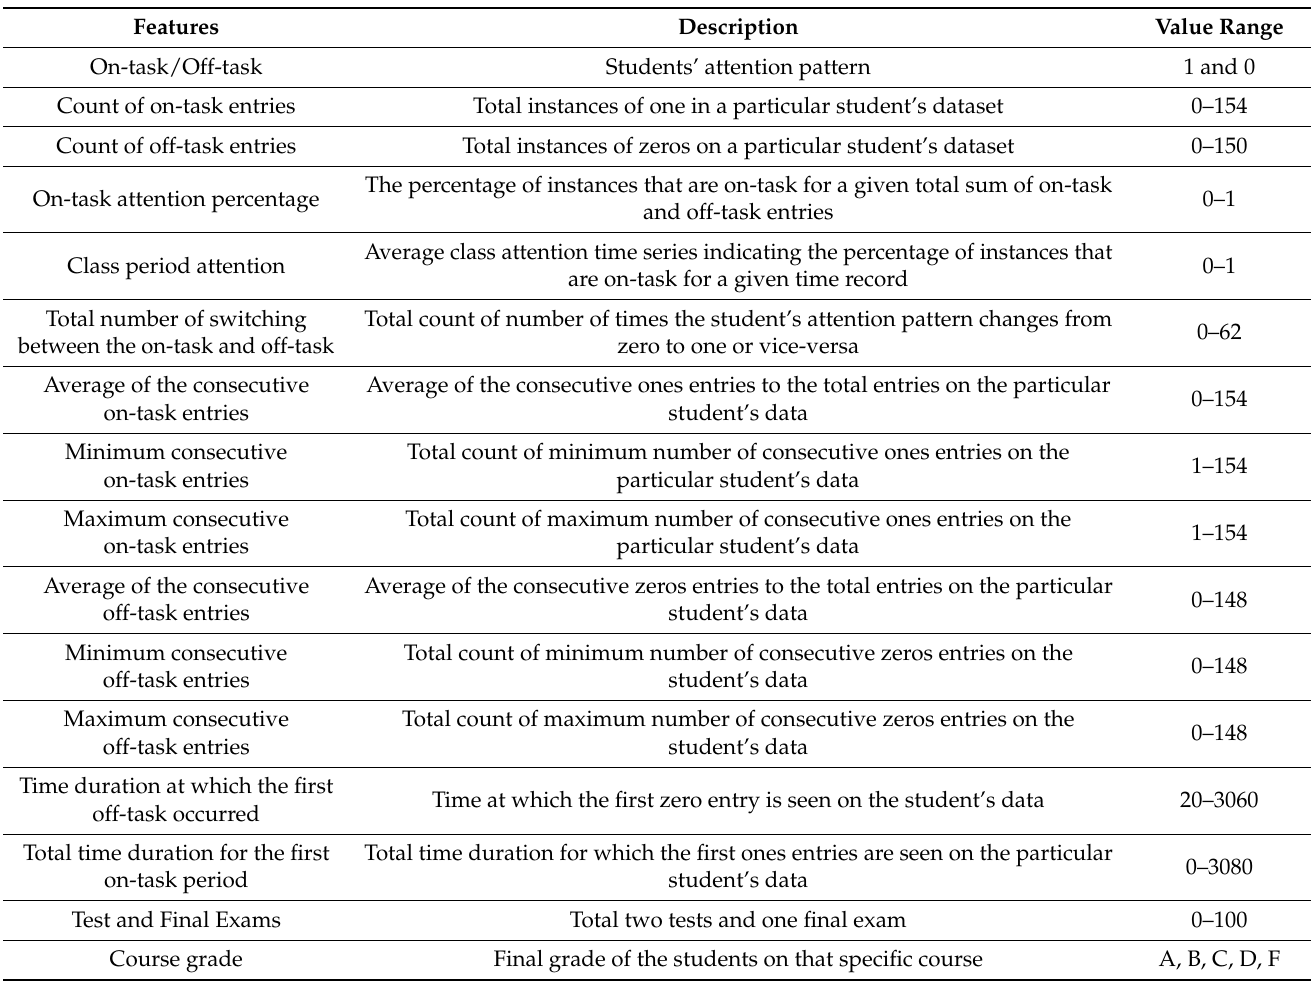
Table 1. Features description of the student’s